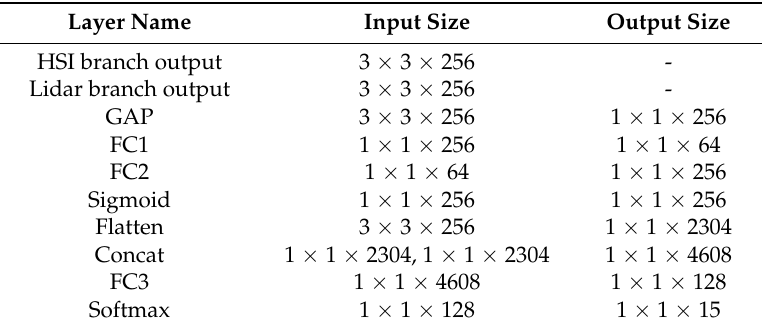
Figure 6. Structure of the adaptive feature-fusion module. C: Concatenate; ×: pointwise production. The configuration of the feature-fusion module is depicted in Table 3, which shows the input and output size of each layer. Table 3. Configuration of the adaptive feature-fusion module.